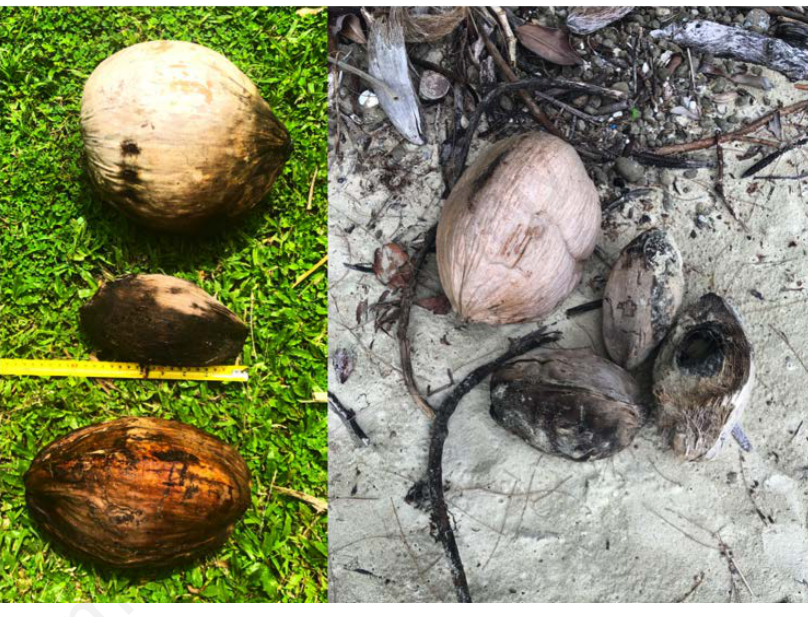
Figure 2. Top Left: A niu vai coconut that is a descendant of the commercial plantation at Wonga Beach. Bottom Left: A nut from a self-sown niu kafa palm found at Rocky Point. Middle Left: a very small wild-type drift nut found on the strand line at Four Mile Beach, Port Douglas. It can also be seen in the picture on the right side. It is a viable nut that is starting to sprout. The coconuts on the right side are drift nuts found on the stand line on Fourmile Beach. There is a niu vai, two small niu kafa nuts and the very small wild-type